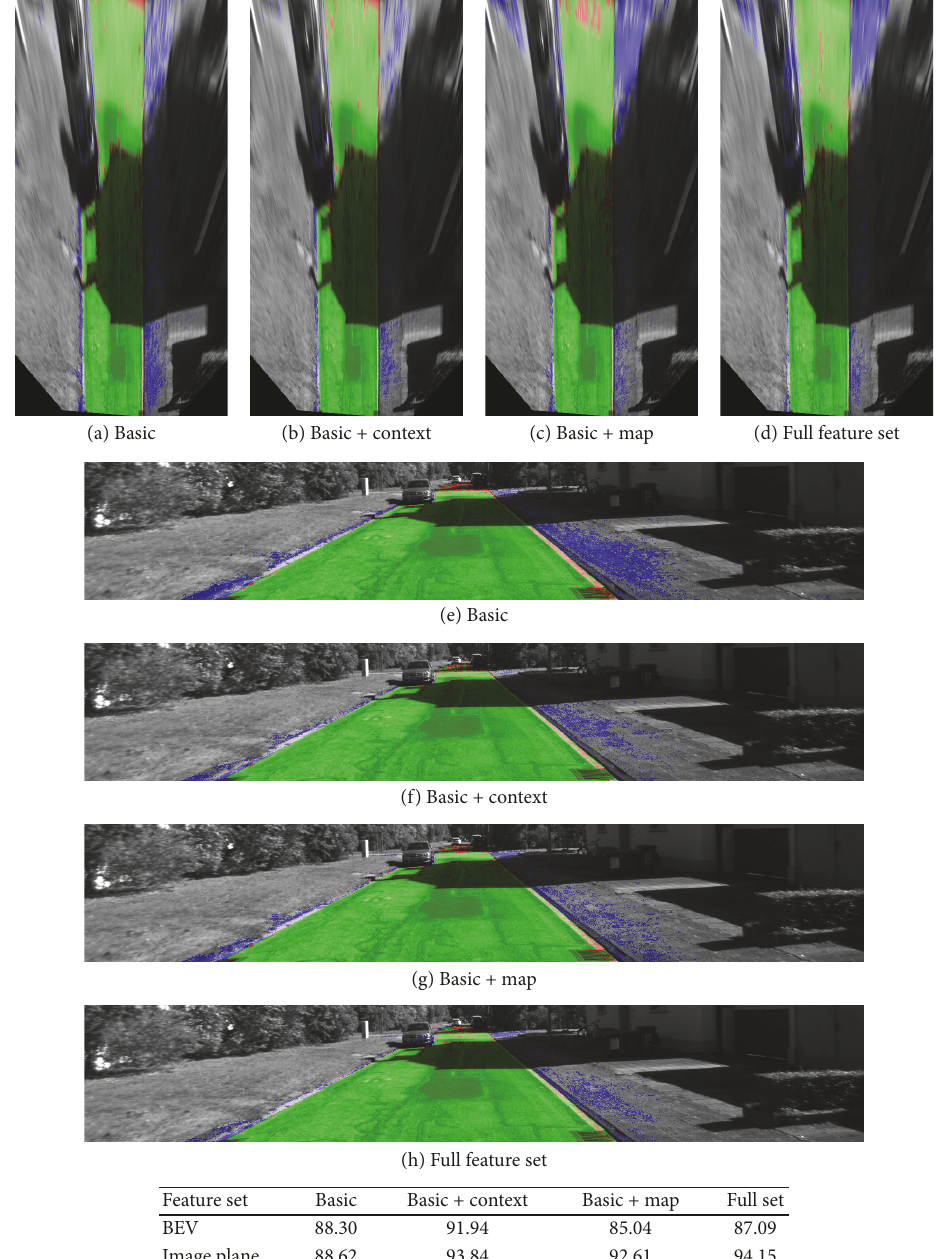
Figure 20: Results of unary terms in a specific UU image. All the features combinations have good results. However, the combination basic + context obtains less false positives, especially at far distances, which is very important in the BEV